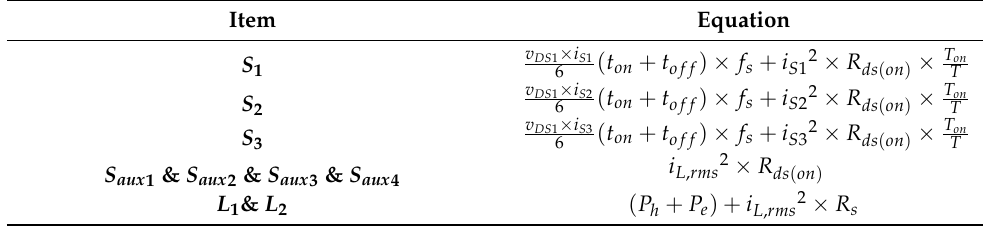
Table 3. Equations to derive the power losses in main components.